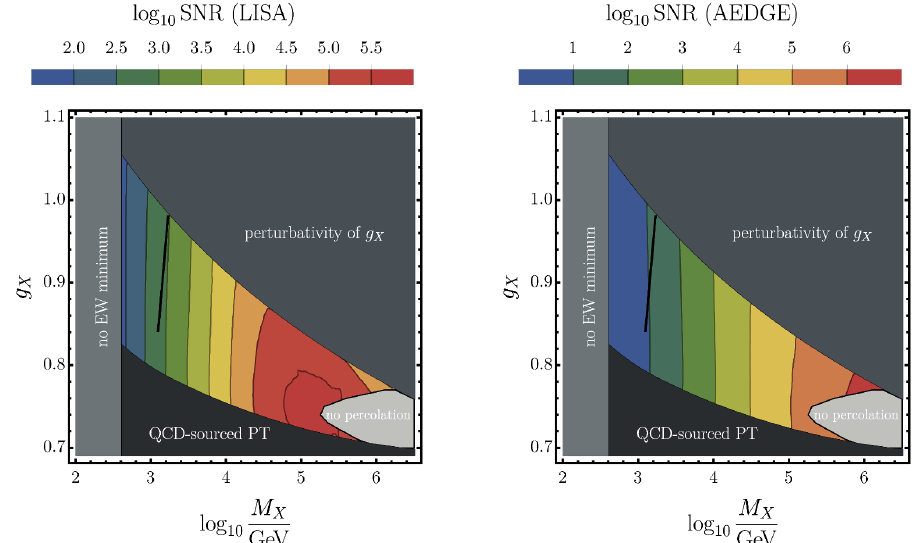
Figure 23 . Results for the signal-to-noise ratio for LISA (left panel) and AEDGE (right panel) for the GW signal according to ref. [154]. The black line corresponds to the points that reproduce the measured DM relic abundance and also evade the DM direct detection experimental